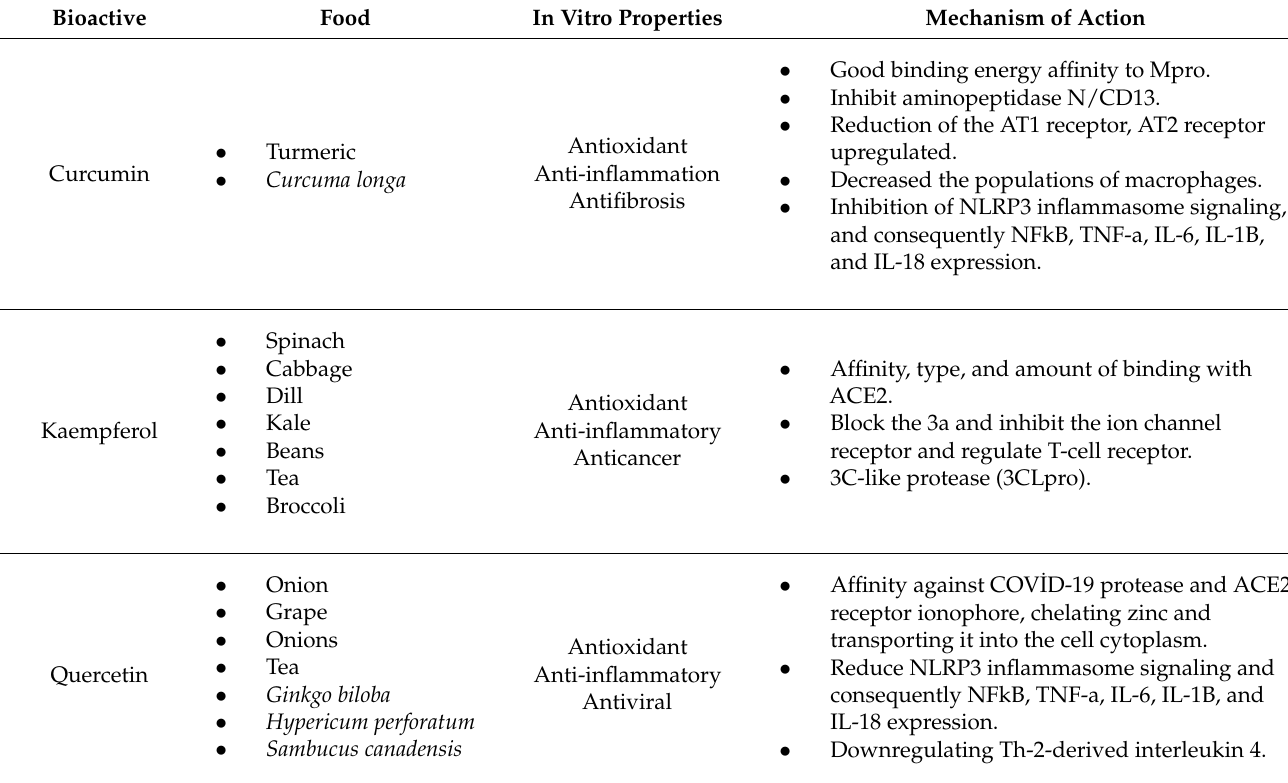
Table 1. Summary of the bioactive compounds selected and potential mechanisms of action.